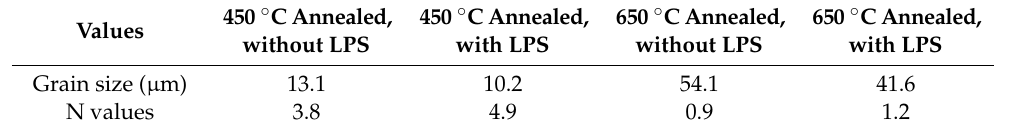
Figure 2. Microstructures of copper foils. ( a ) 450 °C annealed, without LPS; ( b ) 4500 °C annealed, with LPS; ( c ) 650 °C annealed, without LPS; ( d ) 650 °C annealed, with LPS. Table 1. Grain size and N values of copper foils.